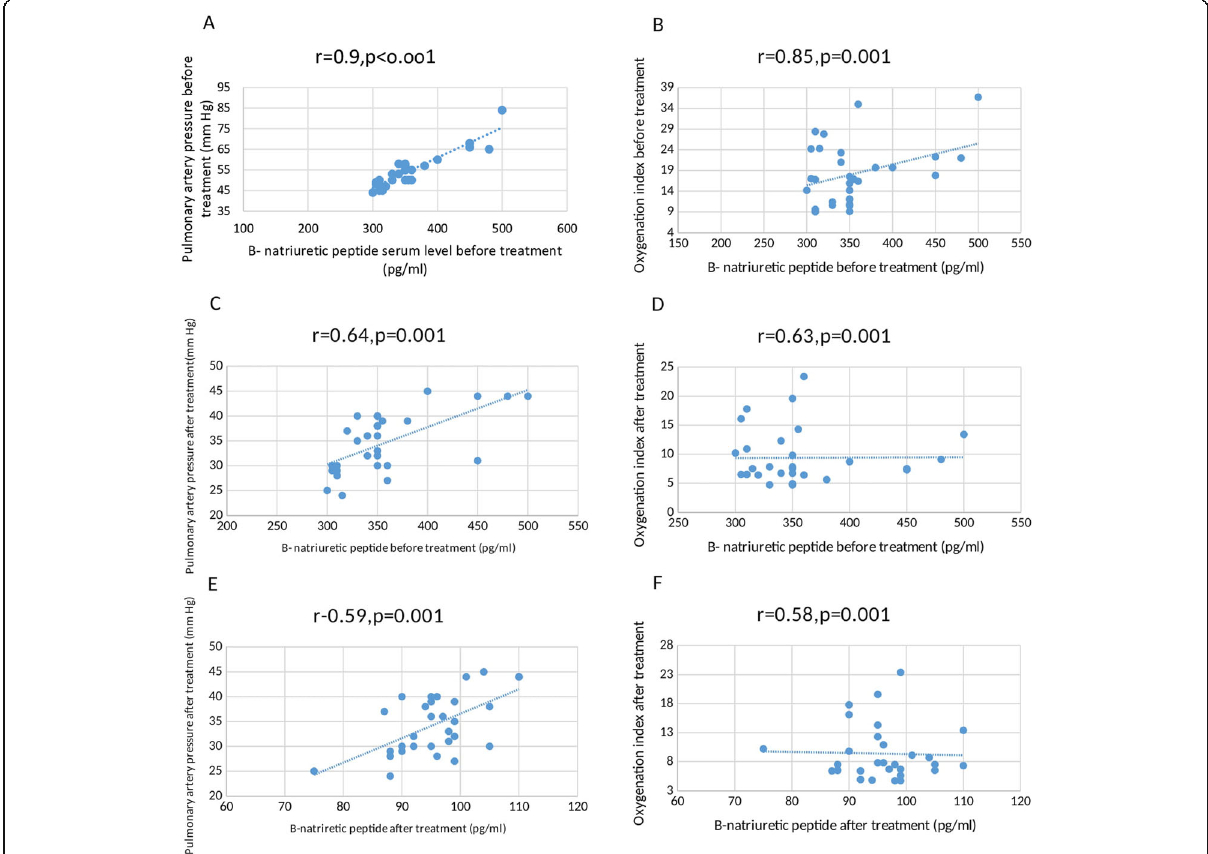
Fig. 3 Correlates of B-natriuretic peptide (BNP) with pulmonary artery pressure (PAP) and oxygenation index (OI). Pearson ’ s correlation analysis revealed that serum levels of BNP before treatment showed strong positive correlations with values of PAP and OI before treatment ( a , b ) and moderate positive correlation with values of PAP and OI after treatment ( c , d ). Moreover, BNP after treatment showed moderate positive correlations with post-treatment values of PAP and OI ( e , f